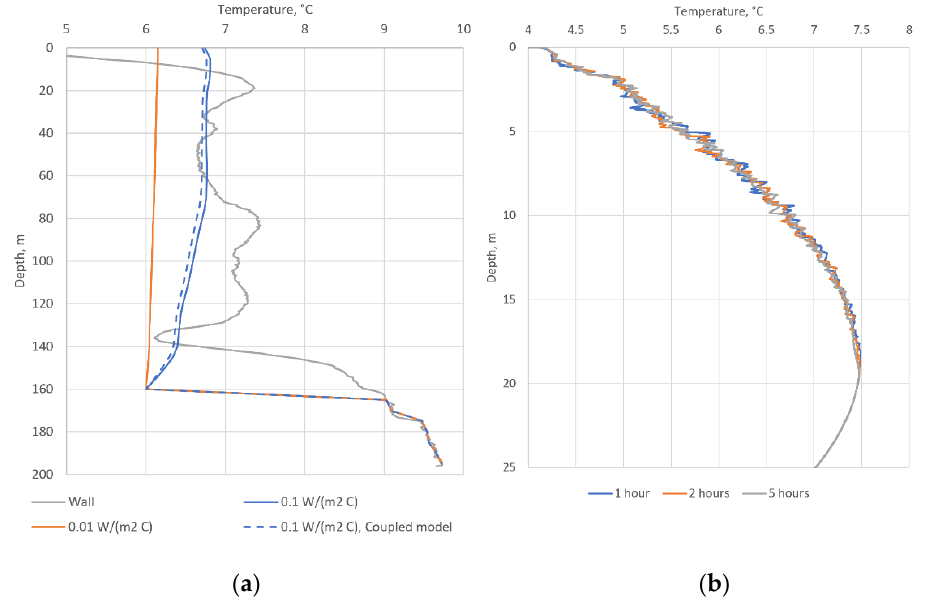
Figure 7. Schemes of convective flows of water in a well in the framework of the first ( a ) and second ( b ) hypotheses.